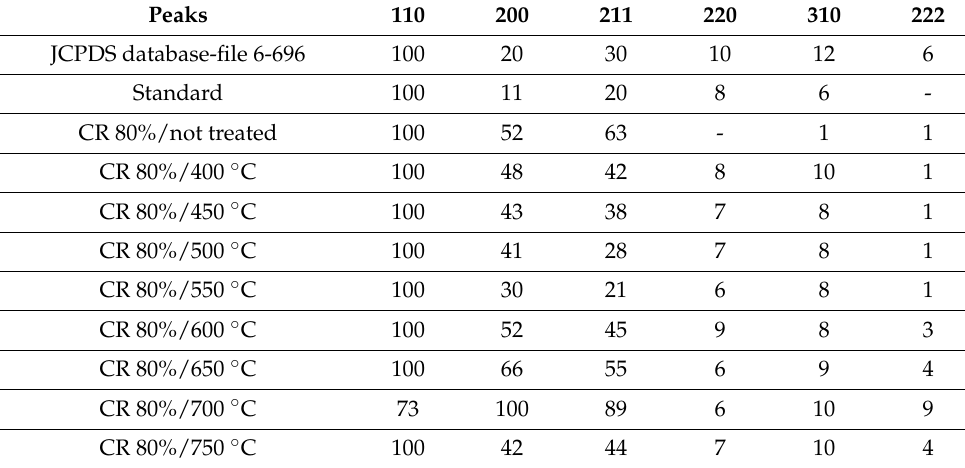
Table 3. Relative intensities of XRD peaks of EUROFER97 steel cold rolled with CR ratio of 80% and heat-treated for 1 h at the reported temperatures (from 400 to 750 ◦ C in steps of 50 ◦ C). The values have been determined from patterns in Figure 10. Data from the file 6-696 of the JCPDS database [59]